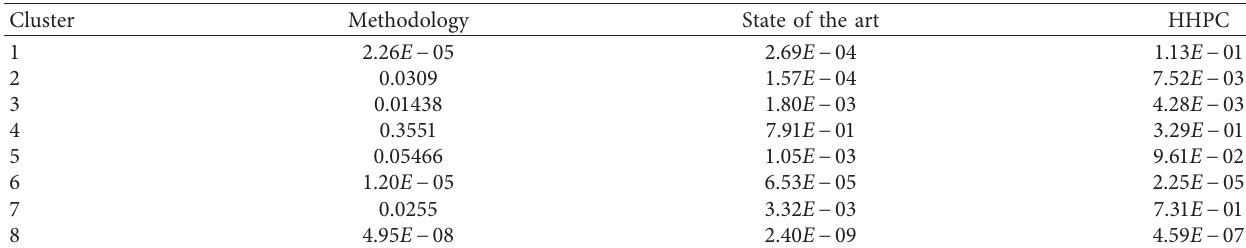
Table 20: Normality test results of the methodology, state of the art, and hyperheuristics with complete pool. Cluster